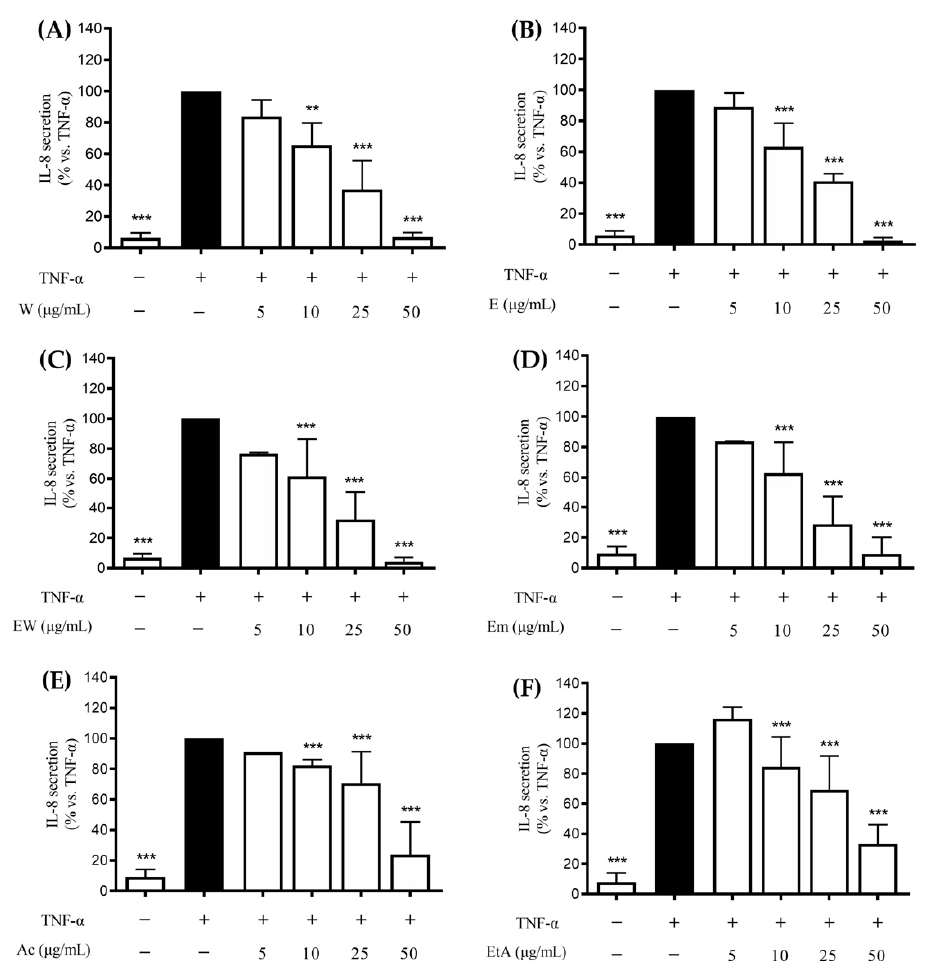
Figure 1. Effects of Rhus coriaria L. extracts (( A ) 100% water (W), ( B ) 100% ethanol (E), ( C ) ethanol– water (ethanol:water 50:50 v / v , EW), ( D ) ethanol macerated (plant material subjected to maceration with pure ethanol for 48 h, Em), ( E ) acetone (Ac), ( F ) ethylacetate (EtA)) on the TNF- α (10 ng/mL) challenged GES-1 cells (6 h). The release of IL-8 was assessed through an ELISA assay. The reference compound (black color) used was EGCG 20 µ M ( − 37%). Data are reported as percentage in compari- son to the stimulated control, which was arbitrarily assigned to 100% value. ** p < 0.01, *** p < 0.001 versus TNF- α . IL-8, interleukin-8; TNF- α , tumor necrosis factor alpha; GES-1, gastric epithelial cells; ELISA, enzyme-linked immunosorbent assay; EGCG, epigallocatechin gallate; − and +, absence or presence of the respective